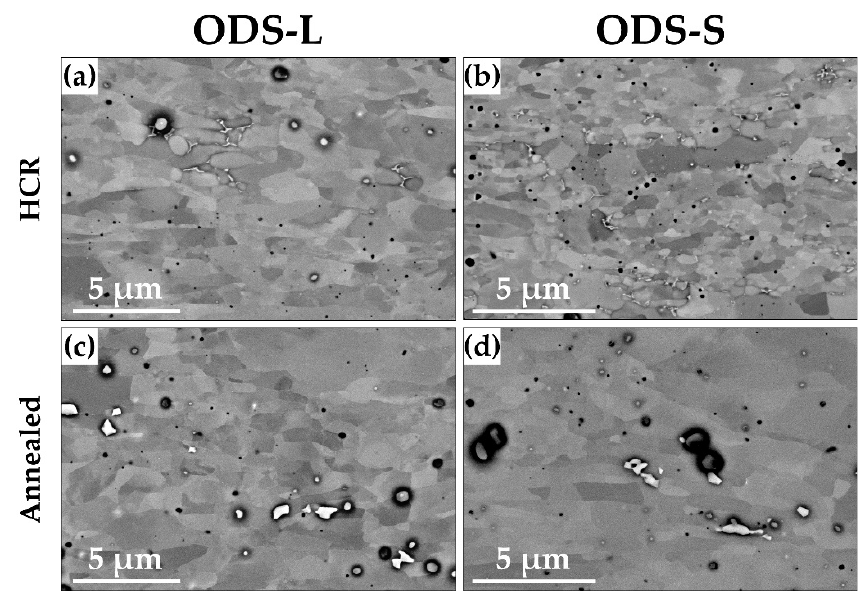
Figure 3. BSE SEM images with low magnification showing the microstructure of the ODS steels on the TS plane after HCR and after annealing at 1273 K. ( a ) ODS-L and ( b ) ODS-S steels after HCR; ( c ) ODS-L and ( d ) ODS-S steels and after annealing at 1273 K; ( e ) plane orientation scheme.